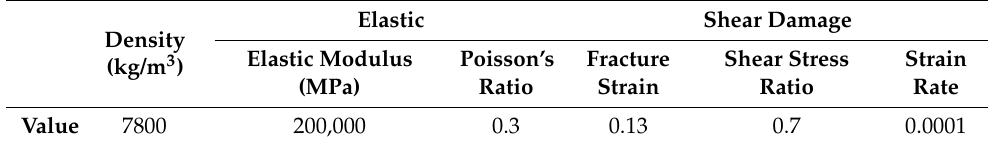
Table 4. Steel bolt material